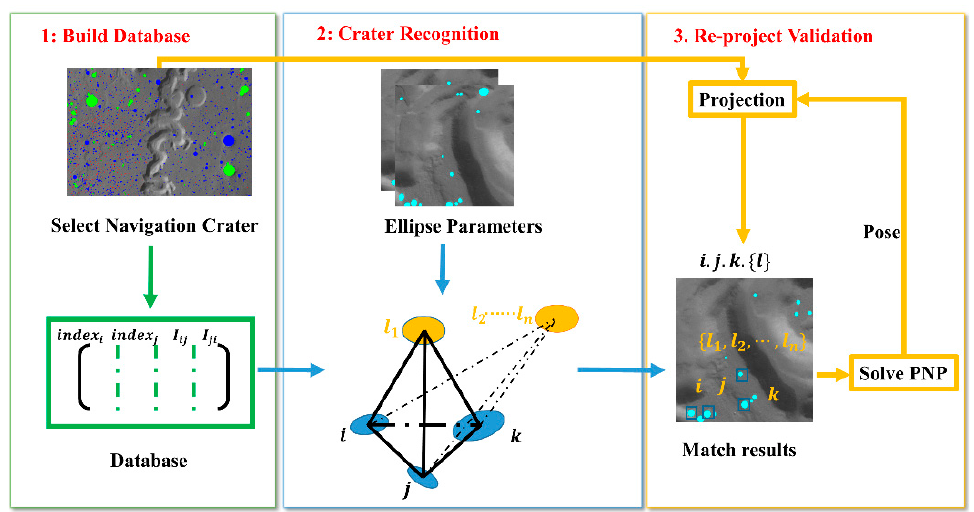
Figure 1. Block diagram of the proposed framework for (1) database establishment, (2) crater recognition, and (3) re-projection validation. In the first part, the navigation craters are selected to establish a database, and I ij and I ji are the invariants of crater pair ( i, j ). In the second part, the crater in the current sequence image is detected to obtain the ellipse parameters, and craters are recognized by an iterative pyramid algorithm. In the third part, the PNP problem is solved, and re-projection validation is performed on all navigation craters.